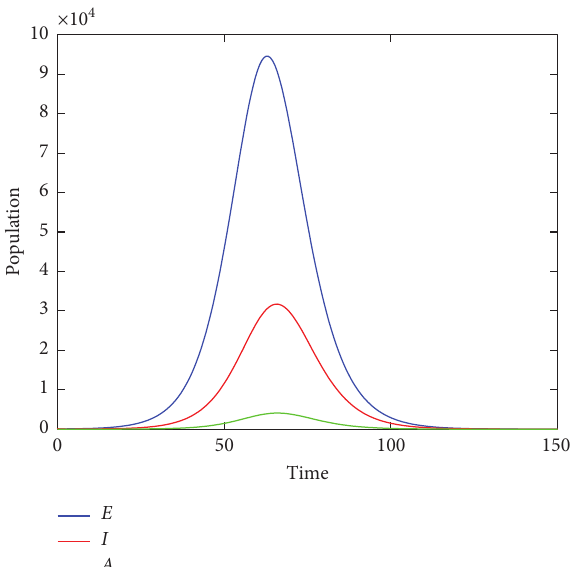
Figure 2: Simulation for the number of Exposed, Symptomatic Infected, and Asymptomatic Infected.